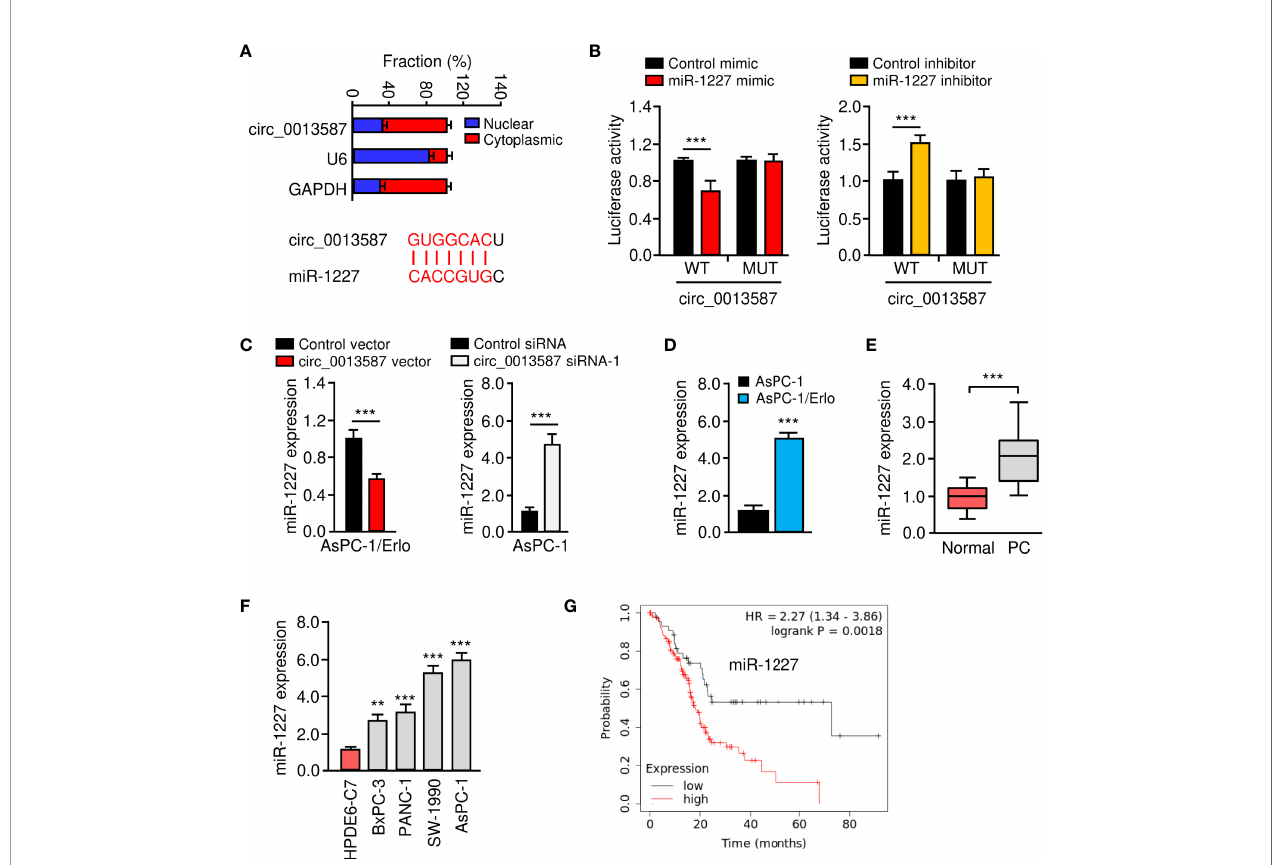
FIGURE 4 | Circ_0013587 sponges miR-1227 in pancreatic cancer cells. (A) The qRT-PCR assay showed the cytoplasmic distribution of circ_0013587 in AsPC-1/ Erlo cells. Lower panel: the schematic diagram of the predicted miR-1227 binding site for circ_0013587. (B) Luciferase activity of WT circ_0013587 or MUT circ_0013587 in AsPC-1/Erlo cells after co-transfection with miR-1227 mimic, and in AsPC-1 cells after co-transfection with miR-1227 inhibitor. (C) qRT-PCR analysis of miR-1227 in the cells transfected as indicated. (D) qRT-PCR analysis of miR-1227 in AsPC-1/Erlo cells and AsPC-1 cells. (E) qRT-PCR analysis of miR- 1227 in pancreatic cancer and adjacent normal tissues. (F) Measurement of miR-1227 expression in pancreatic cancer cell lines and normal pancreatic cells. (G) Kaplan-Meier curves in pancreatic cancer patients with high or low expression of miR-1227. ** P < 0.01, *** P